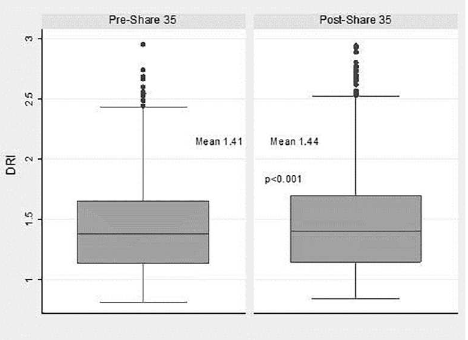
Fig 4. Distribution of donor risk index in patients undergoing liver transplantation for hepatocellular carcinoma in Era 1 (Pre-Share 35) and Era 2 (Post-Share